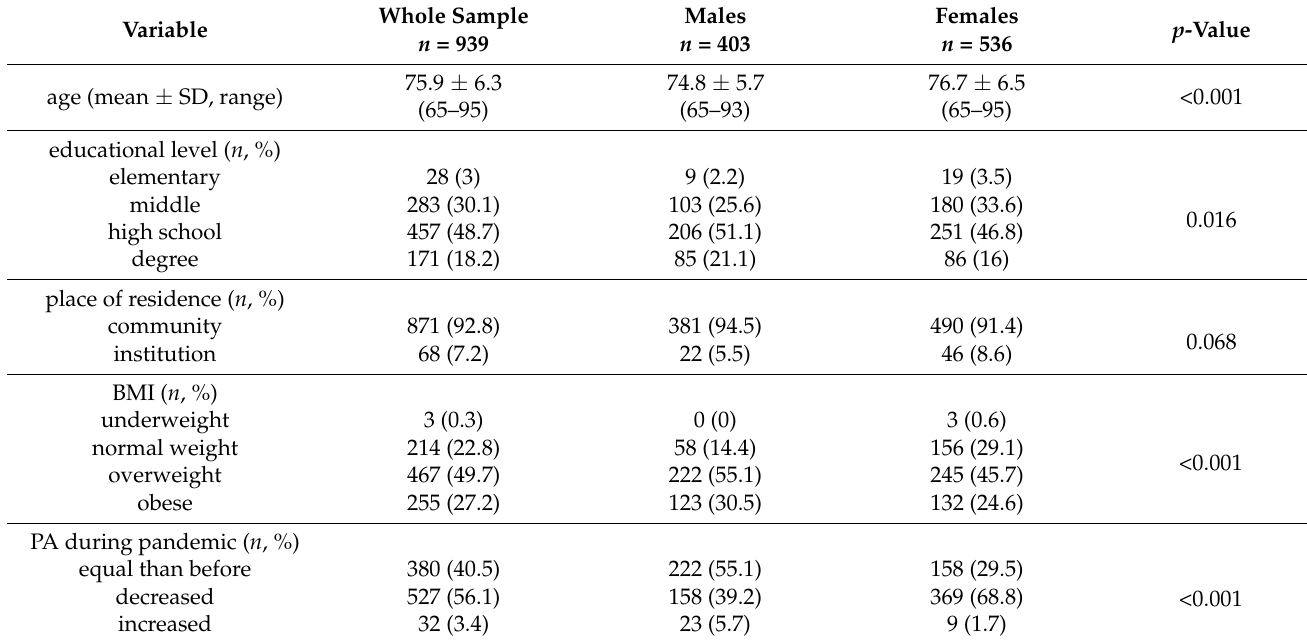
Table 2. Sociodemographic and anthropometric characteristics of